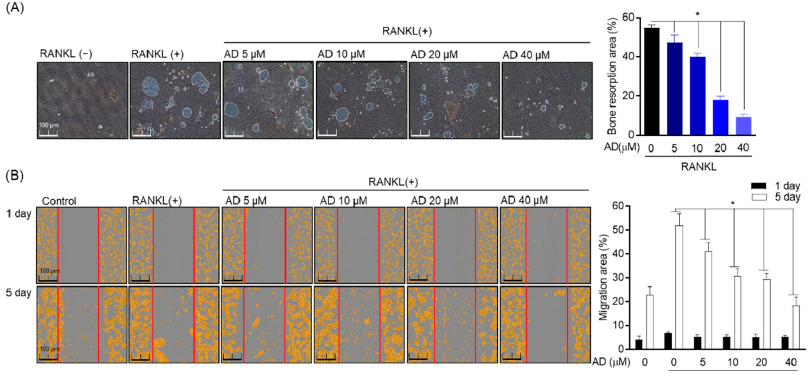
Figure 4. Inhibitory effect of AD on RANKL-induced osteoclast of functions. ( A) RAW 264.7 (1 × 10 3 cells/well) were cultured in osteo-surface well and treat with RANKL (50 ng/mL) to activate osteoclast formation and incubate for 7 days. Incucyte ® Live Cell analysis systems and ImageJ program were used to observe and quantify the percentage of bone resorption pit area to the total osteo-surface well area. ( B ) Red lines indicate the migration borders at the beginning of the assay. Cell migration was analyzed on the first day and the fifth day after treatment. * p < 0.05, versus the RANKL-treated group.